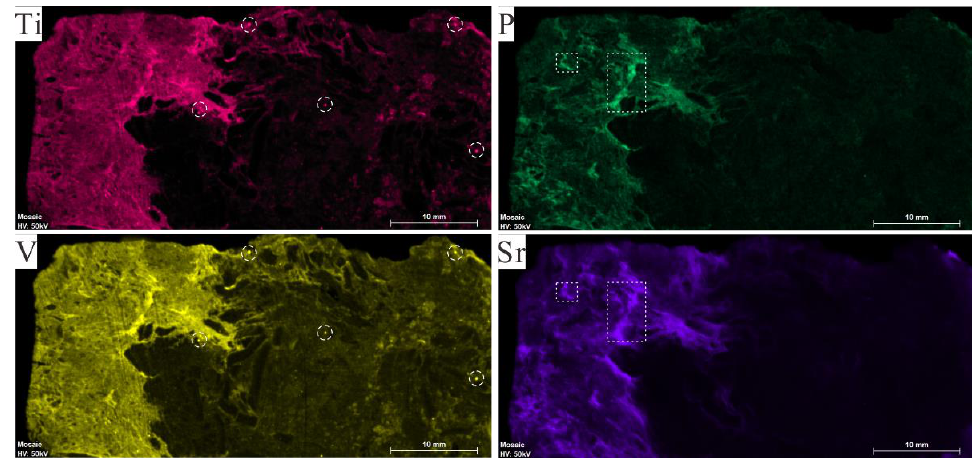
Figure 11. Elemental maps of Ti, V, P, and Sr in the sample Y1 obtained by the scanning μXRF mapping technique. The circular boxes represent the highly overlapping areas of the elements Ti and V; the rectangular boxes represent the highly overlapping areas of the elements P and Sr.